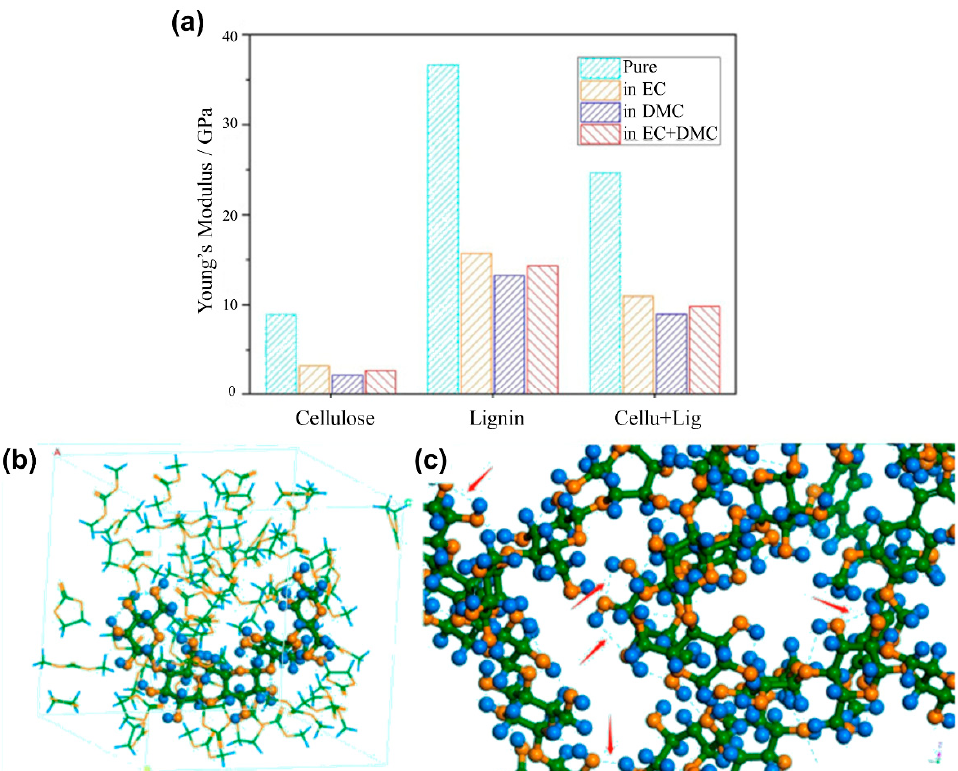
Figure 6. Simulation results from Xie et al. [47] ( a ) simulated Young’s modulus of molecular models under different environments, and distinct details in blended models: ( b ) deformed cellulose amorphous model in electrolyte solvents and ( c ) generated hydrogen bonds between cellulose and lignin molecules.